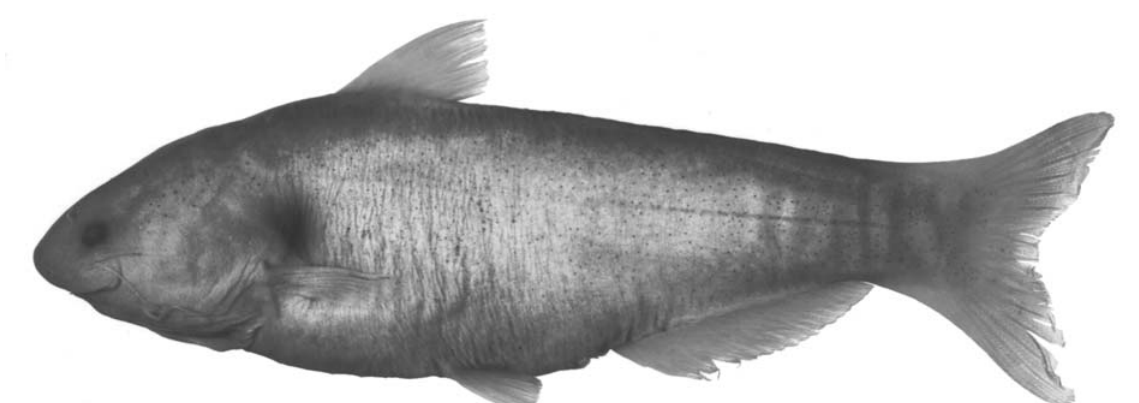
Fig. 42. Cetopsis sarcodes , new species , holotype, MNRJ 13024, 69 mm SL; Brazil, Goiás, Município de Minaçu/Cavalcante, rio Tocantins between site of future dam of Usina Hidroeléctrica Cana Brava and Ilha do Orgulho and Porto do